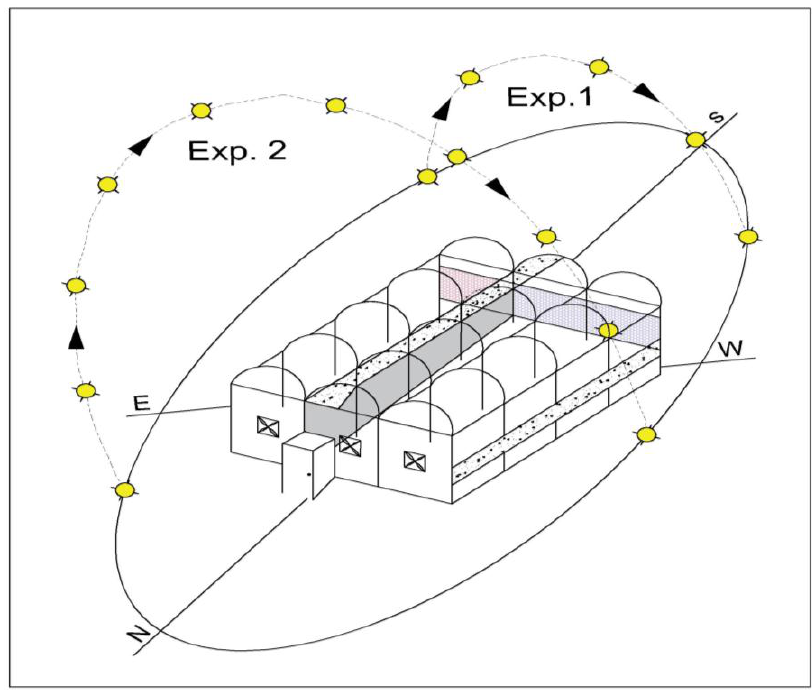
Figure 1. Greenhouse layout and sun orientation during autumn–winter (Exp. 1) and spring (Exp. 2) cropping seasons.